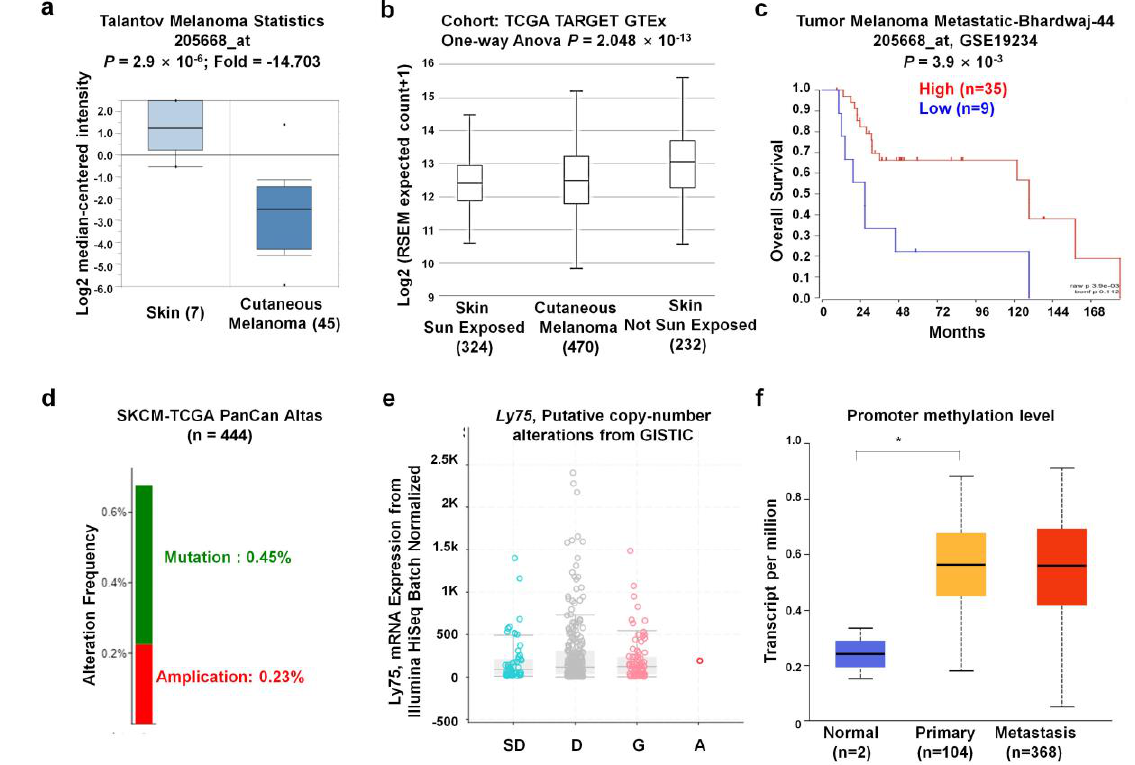
Figure 3. Ly75 expression and genome alterations in SKCM. ( a ) The boxplot of Ly75 expression in cancer tissues (right plot, n = 45) and normal (left plot, n = 7) was retrieved from the Talantoy melanoma dataset in the Oncomine database. ( b ) Ly75 expression in normal skin of sun-exposed (Lower Leg) and non-sun-exposed (Suprapubic) skin, and melanoma datasets from TCGA, TARGET, and Genotype-Tissue Expression (GTEx) in the University of California, Santa Cruz (UCSC) Xena browser (http: // xena.ucsc.edu / ). ( c )TheKaplan–MeiersurvivalcurvesofthetwopatientgroupsofTumorMelanomaMetastatic-Bhardwaj-44 dataset split by Ly75 expression with “scan” option. A group has higher Ly75 expression denoted by red color and lower expression by blue color using R2: platform (https: // hgserver1.amc.nl / cgi-bin / r2 / main.cgi). ( d ) The mutation and alteration frequencies of the Ly75 gene were determined from the SKCM (TCGA, PanCan atlas) ( n = 444) dataset using the cBioPortal database (https: // www.cbioportal.org / ). ( e ) Correlation of Ly75 mRNA expression and copy number alteration status in terms of shallow deletion (SD), diploid (D), gain (G), and amplification (A). ( f ) Promoter methylation of Ly75 was examined from the TCGA-SKCM dataset through the UALCAN web tool (http: // ualcan.path.uab.edu /